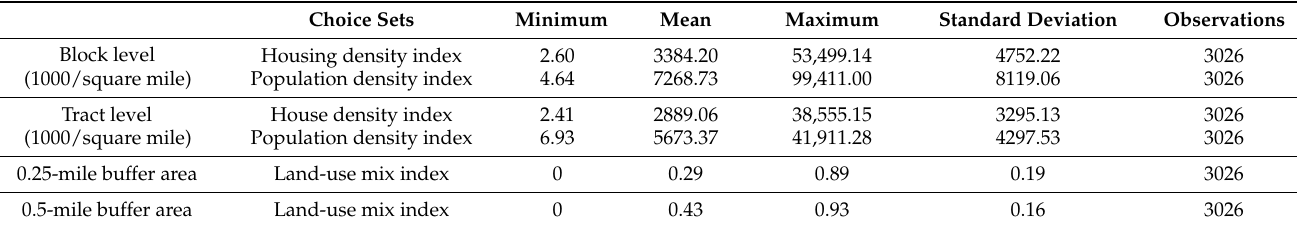
Table 1. Descriptive statistics of six types of choice alternatives.